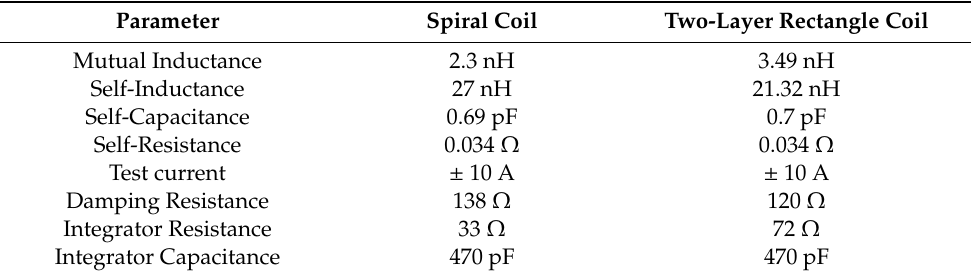
Table 3. Circuit parameters of current sensor.